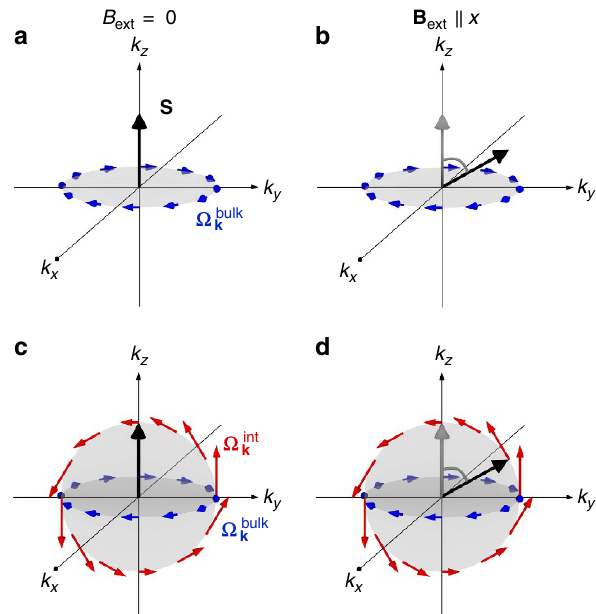
Figure 5 | Interface-induced SOC effects on the spin relaxation in WZ GaAs/AlGaAs core/shell NWs. ( a , b ) Schematic explanation of the spin relaxation anisotropy in bulk WZ crystals: ( a ) for B ext ¼ 0 the optically generated spin ensemble S pointing along the ^ c axis is susceptible to both , while ( b ) Larmor precession the x - and y -component of the SOC field O bulk k in an external magnetic field B ext || x leads to a rotation of S towards k y , which is then only subject to the x -component. ( c , d ) Schematic model for the observed spin relaxation in WZ GaAs/AlGaAs core/shell NWs, involving interface-induced SOC at the ð 11 (cid:2) 20 Þ sidewall facet: ( c ) for B ext ¼ 0 the optically generated spin ensemble S pointing along the ^ c axis is not susceptible to the largest component O int of the SOC fields, while ( d ) as k ; z soon as an external magnetic field B ext || x induces spin precession, this large z -component of O int starts to act on S and will quickly dominate the k